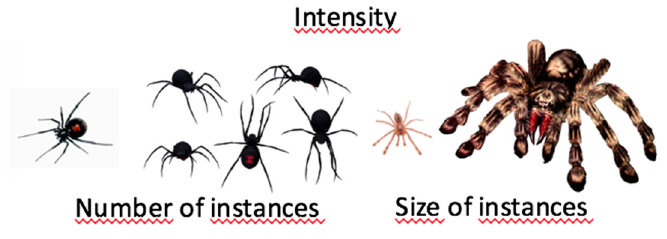
Figure 6. Example of intensity: number of instances and size of the